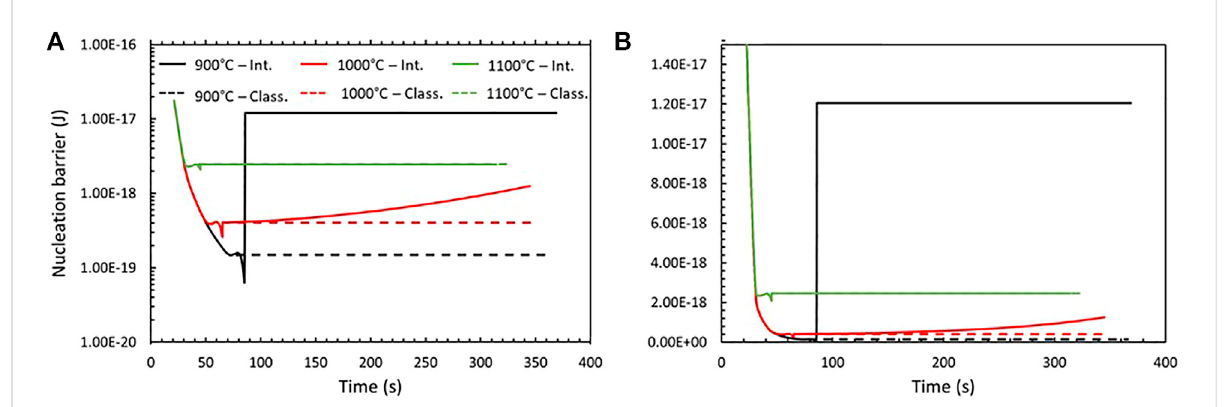
FIGURE 4 Evolution of the nucleation barrier as a function of time in log scale (A) and normal scale (B) for holding at 900 ° C (black), 1,000 ° C (red), and 1,100 ° C (green) using the integrated modeling tool (plain lines) and the classical precipitation model (dashed